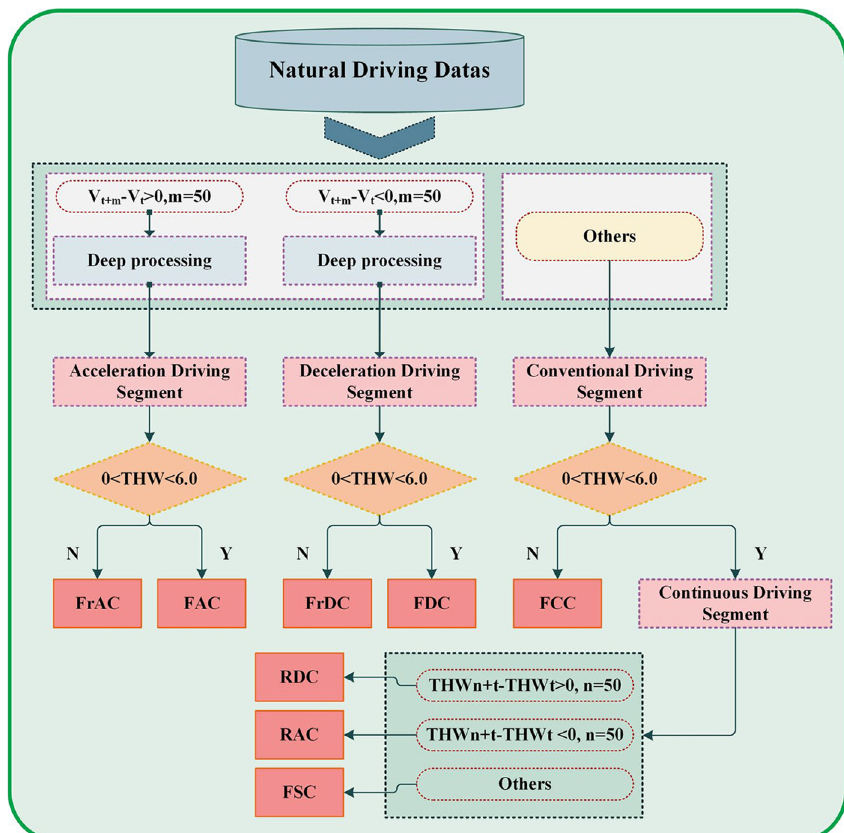
Figure 6 Label process of DOCs